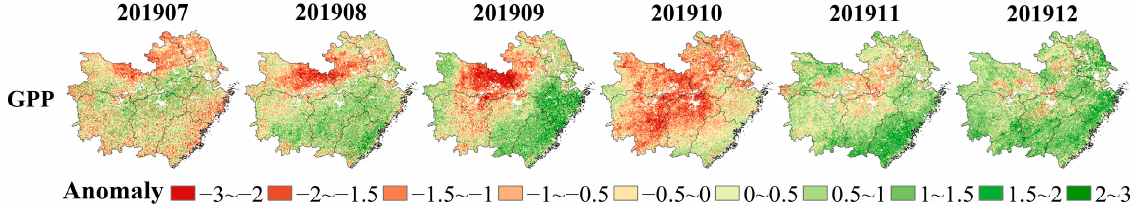
Figure 11. Variation of MODIS GPP from July to December in 2019. Note: The black curve denotes the multi-year monthly average of GPP during 2011–2020; the red curve denotes the monthly average GPP in 2019; the grey shaded areas denote the ±1 standard deviation of the multi-year monthly averages.